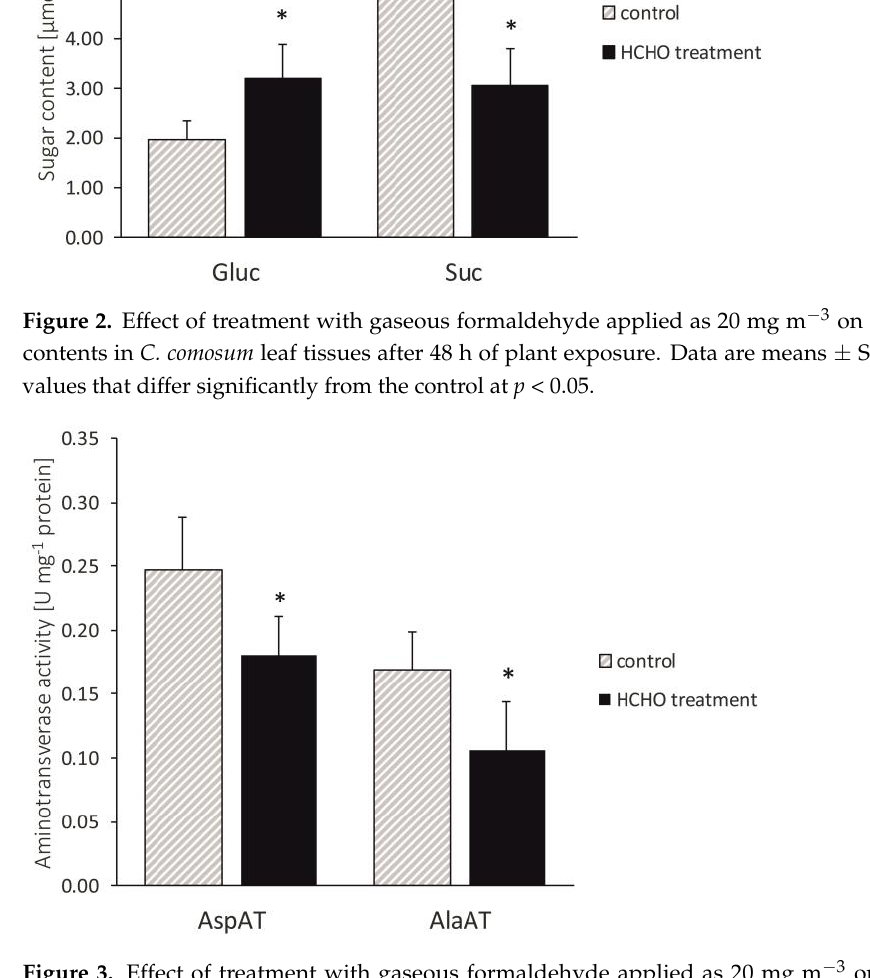
Figure 2. Effect of treatment with gaseous formaldehyde applied as 20 mg m − 3 on Gluc and Suc contents in C. comosum leaf tissues after 48 h of plant exposure. Data are means ± SD. * indicates values that differ significantly from the control at p < 0.05.